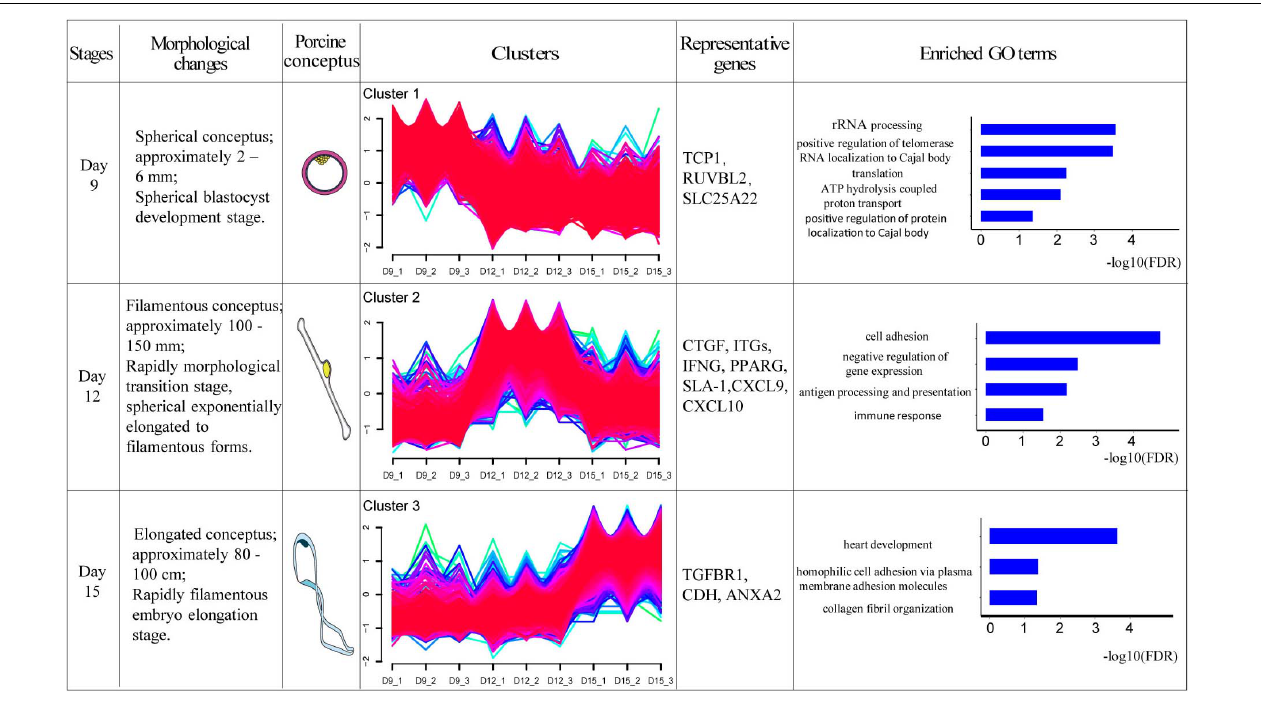
FIGURE 5 | Transcriptome dynamics during porcine conceptus implantation development. The DEGs were clustered into three soft partitioning clusters, with distinct clusters falling into different morphological stages based on expression patterns. GO enrichment was then performed on each cluster of genes and the GO term represented was displayed (FDR < 0.05). Morphological changes briefly described the development of conceptus at this stage. Porcine conceptus represented the pattern diagrams of conceptus. TCP1: T-complex 1; RUVBL2: RuvB-like AAA ATPase 2; SLC25A22: solute carrier family 25 member 22; CTGF: connective tissue growth factor; ITGs: integrins, IFNG: interferon gamma; PPARG: peroxisome proliferator activated receptor gamma; SLA-1: MHC class I antigen 1; CXCL9: chemokine ligand 9; CXCL10: chemokine ligand 10; TGFBR1: transforming growth factor beta receptor 1; CDH: cadherin 11; and ANXA2: Annexin